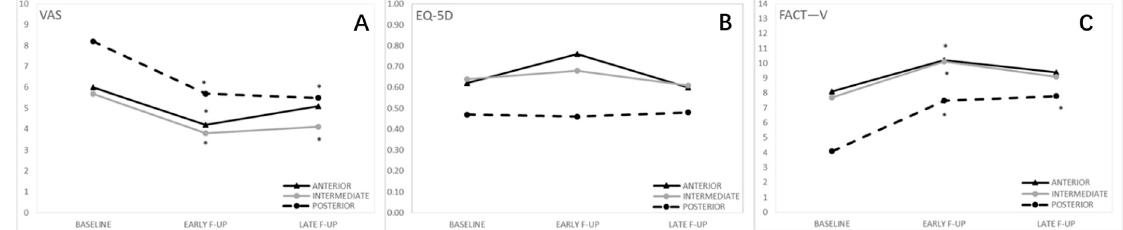
Figure 3. Quality of life by type of anatomical site of the lesion(s). ( A ) Visual analog pain scale (VAS); ( B ) Functional Assessment for Cancer- Vulva (FACT-V); ( C ) EuroQol 5-Dimension 5-Level (EQ-5D-5L). Posterior lesions result in reduced quality of life with all questionnaires administered. *